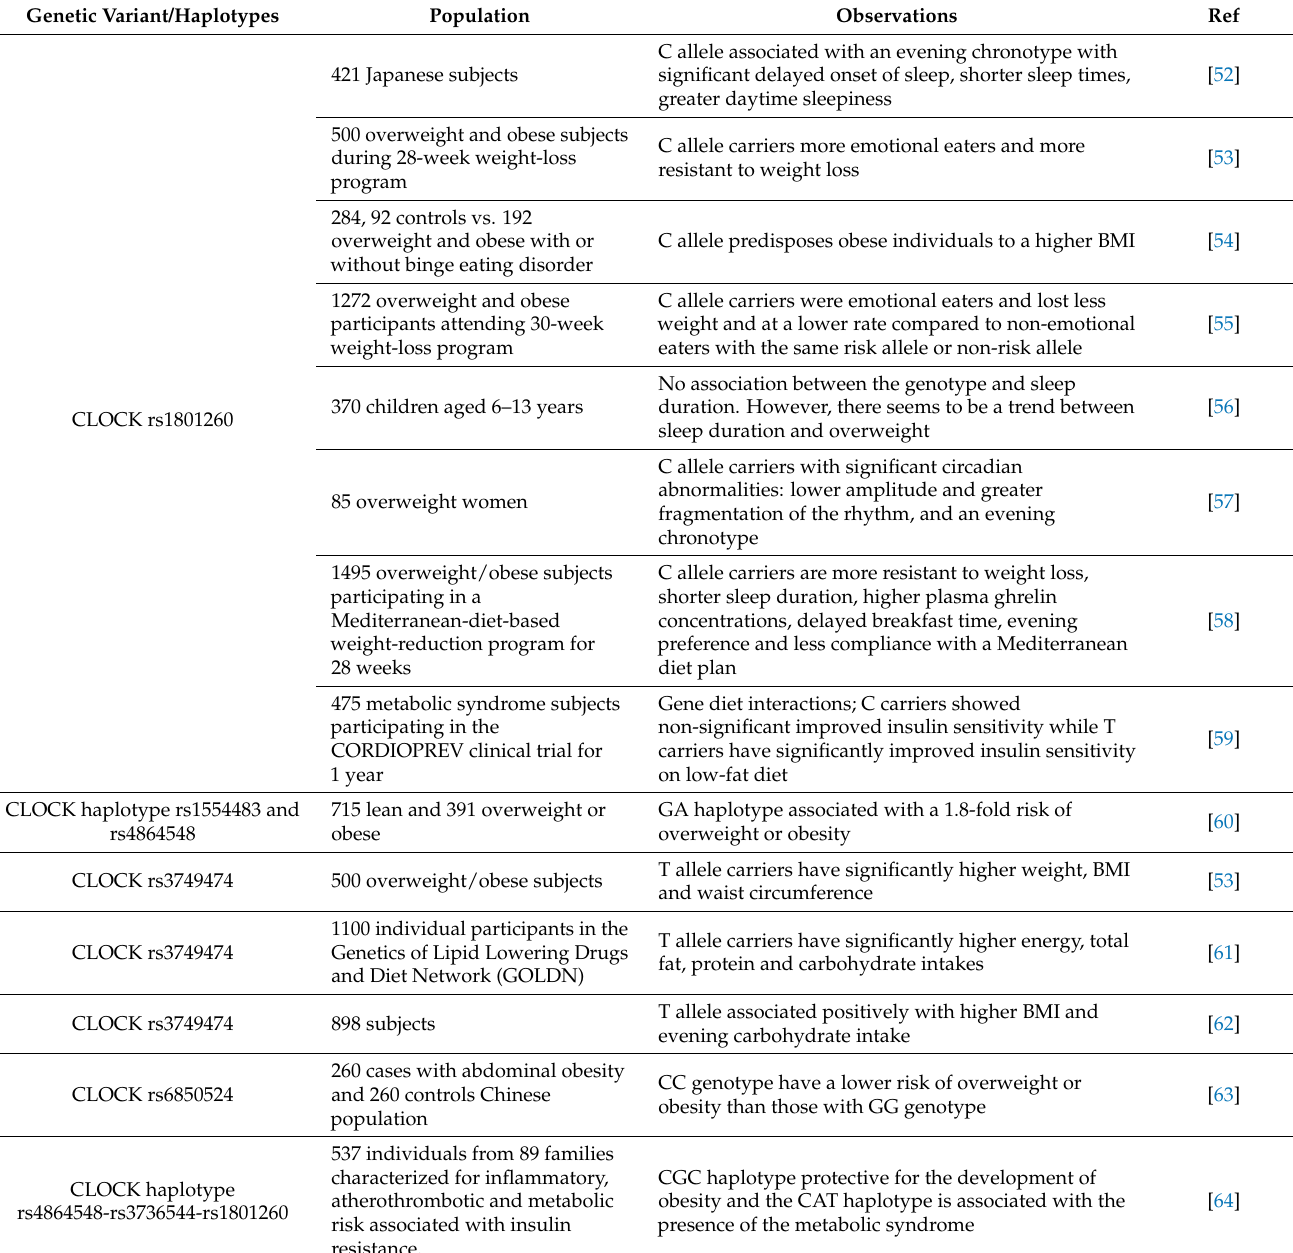
Table 1. A summary of genetic variants in clock components and their associations with chronotypes, eating behaviours and health